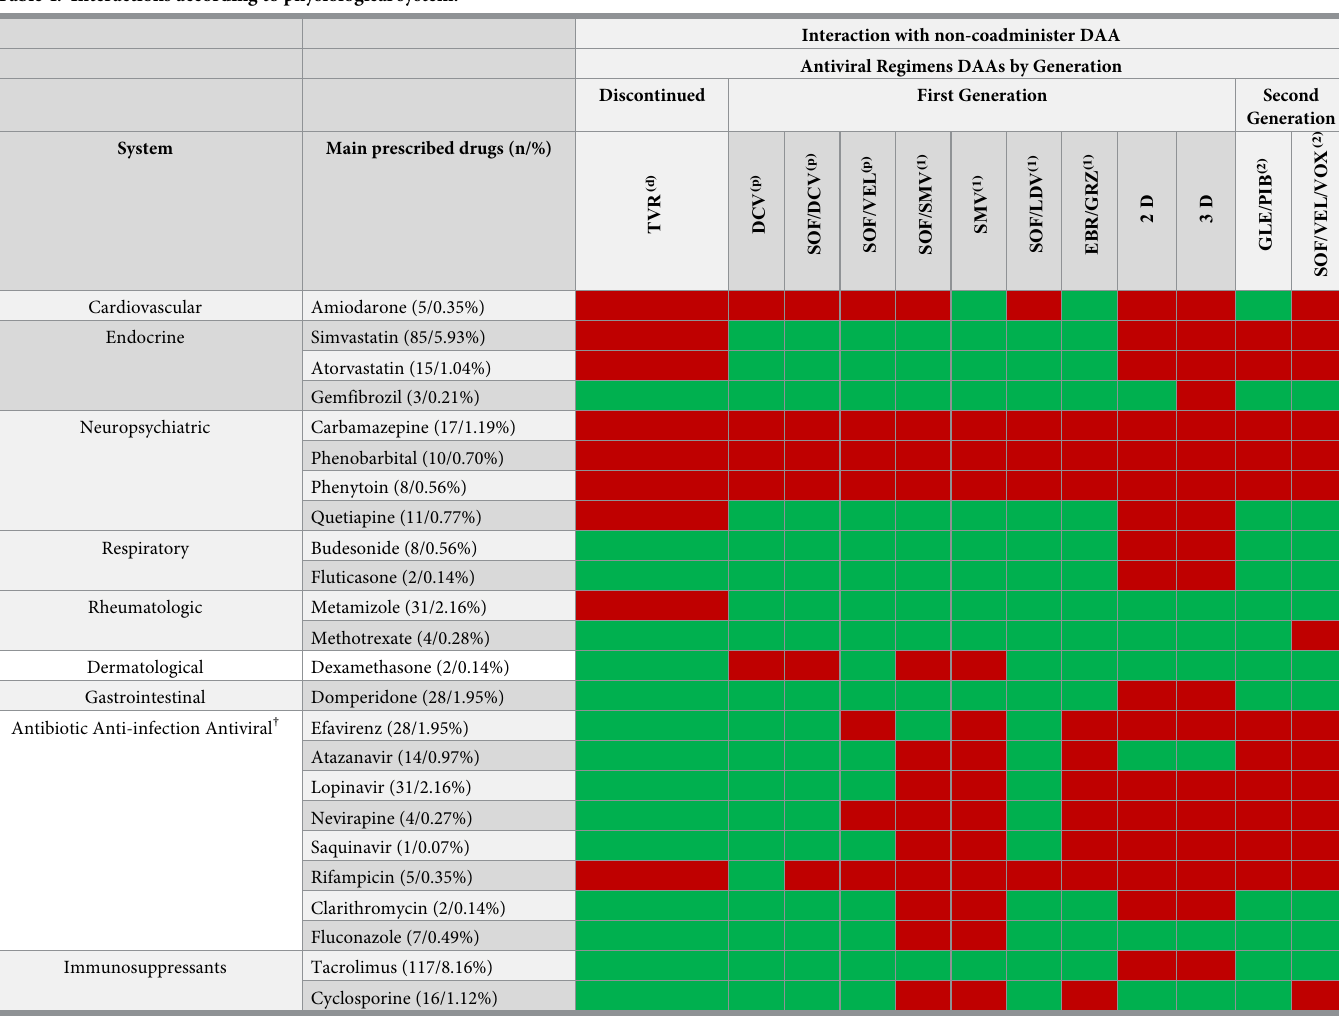
Table 4. Interactions according to physiological system.